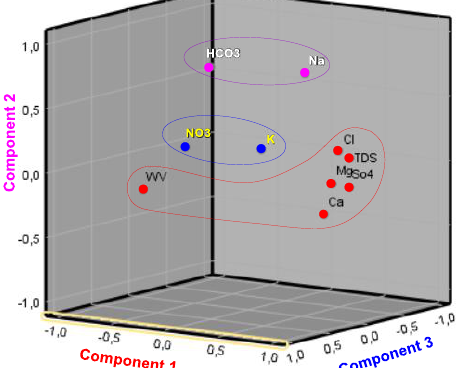
Fig. 5. PCA in 3D scatterplots of sampling water during the period from 2009 to 2013